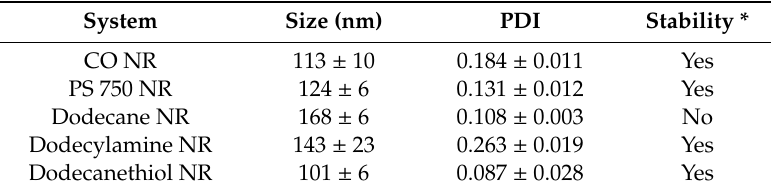
Table 1. Size and stability of various nanoreactor prepared via flash nanoprecipitation.